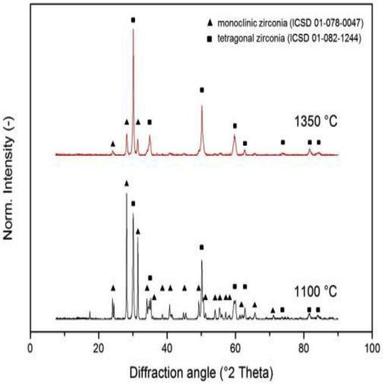
X-ray diffraction pattern of the 3Y–Zr fibers sintered with a heating rate of 1 K/min a) 1100 °C and b) 1350 °C.